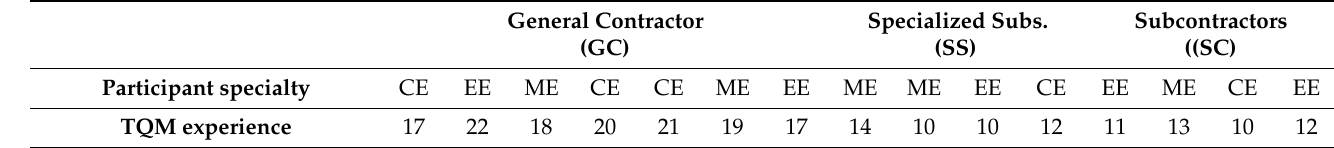
Table 5. Participant expertise (source: own study).